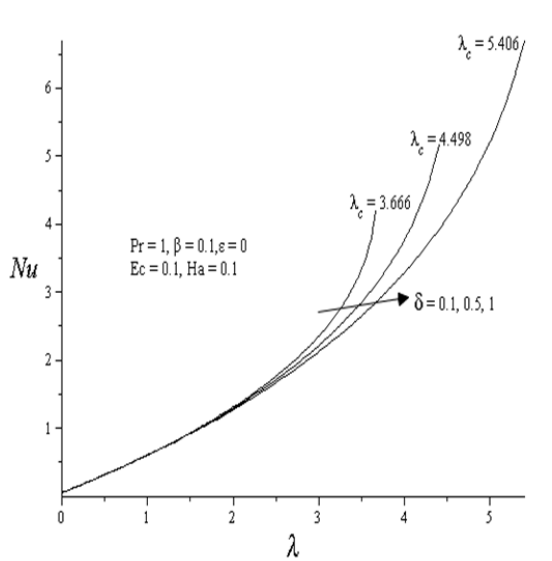
c =thermal critical-